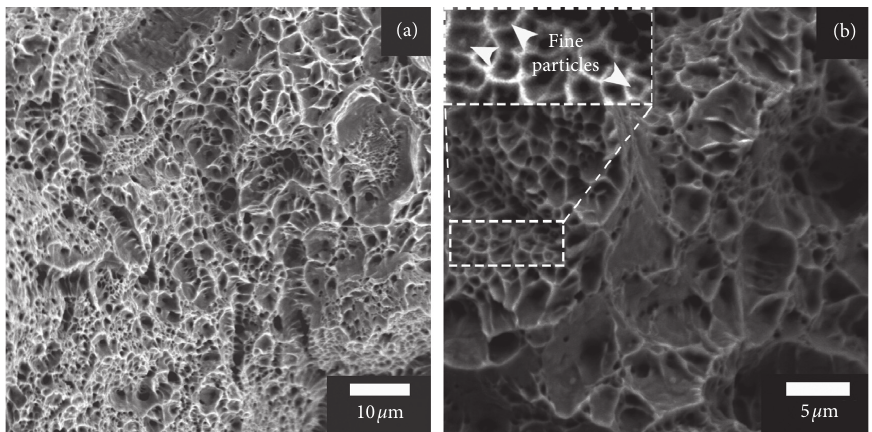
Figure 9: Representative SEM images of the fracture surface from the longitudinal (L1–L6) tensile samples of PWHTed CA6NM that failed in the FZ.